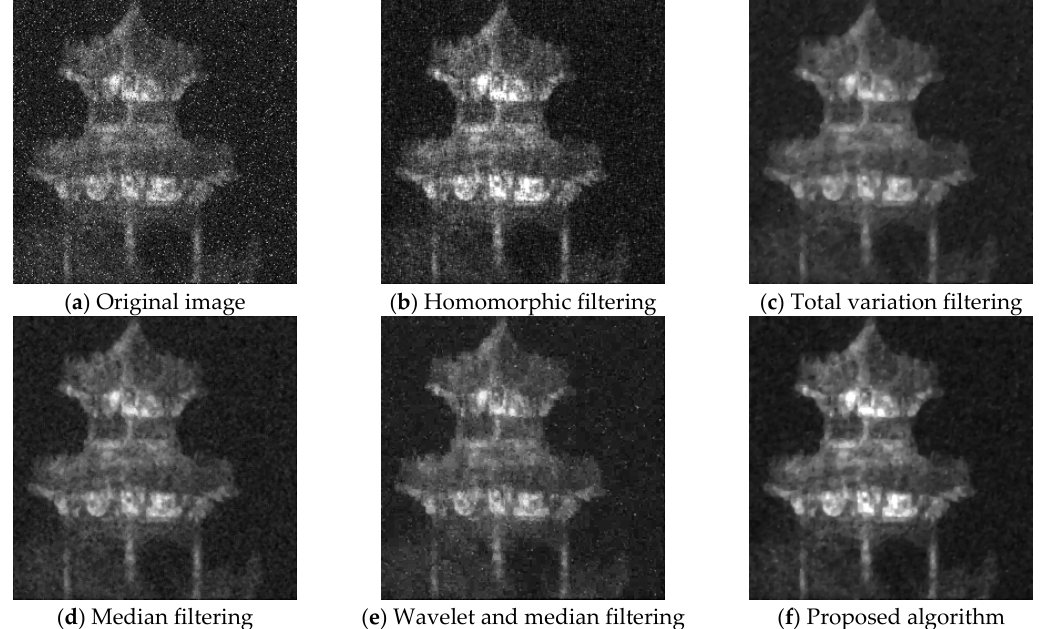
Figure 12. ( a – f ) Noise reduction effect of different algorithms.